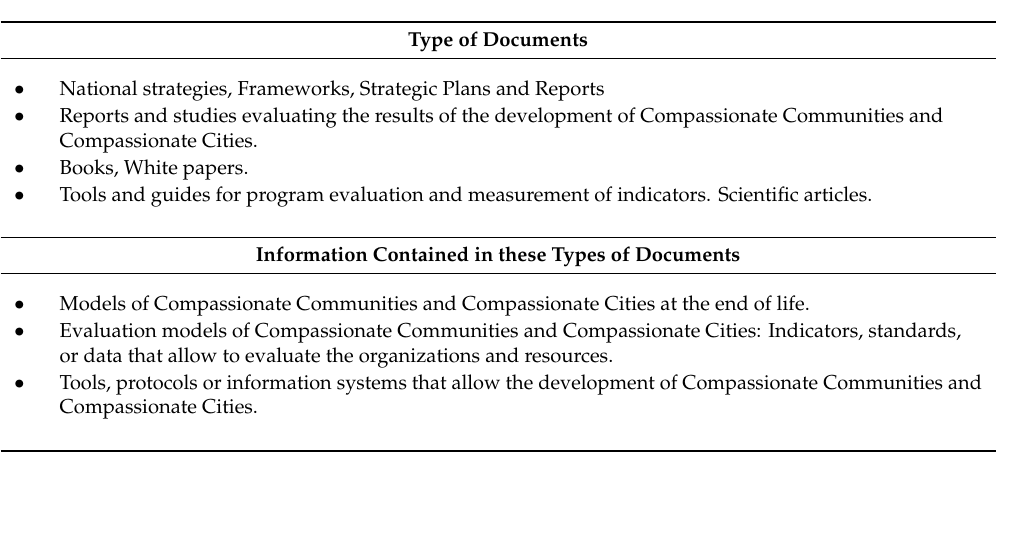
Table 2. Inclusion